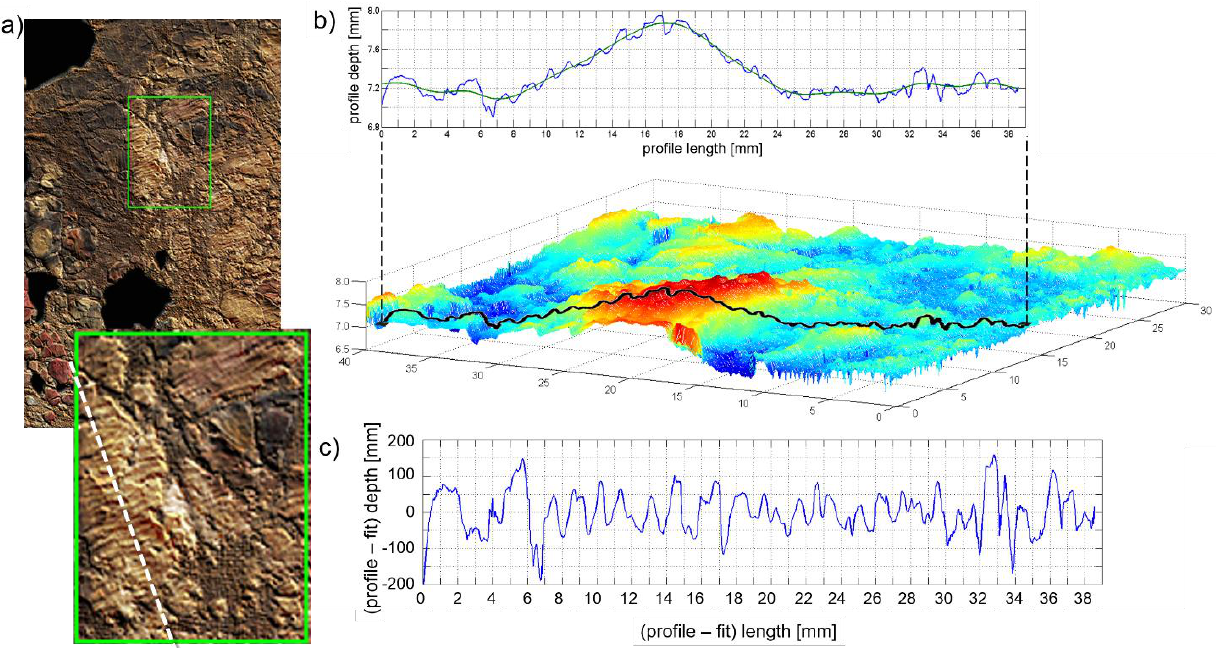
Figure 6. ( a ) Detail of the topographic map superimposed on the RGB image; the white dashed line indicates the location of one of the profiles extracted for the measurement of the grooves. The topographic map ( b ) provided the profile of the surface, from which the surface shape was subtracted ( c ).